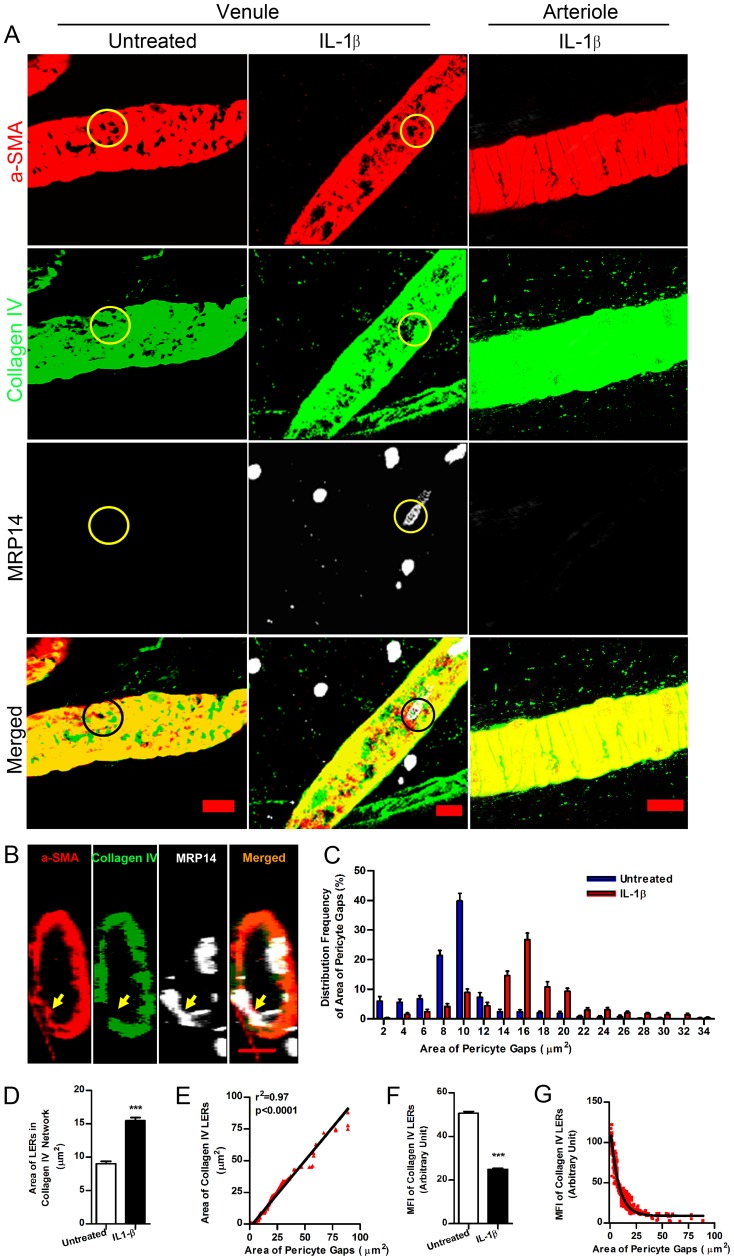
Expansion of pericyte gaps and collagen IV LERs in IL-1β-stimulated venular walls.(A) 3D images of vessel walls in mouse cremaster muscles in the presence and absence of IL-1β revealed pericyte gaps and collagen IV LERs (circled areas) in venules. α-SMA (a marker of venule pericytes and arteriole smooth muscles), collagen IV (a vascular BM marker) and MRP14 (a PMN marker). (B) Cross-sectional images revealed PMNs migrating through pericyte gaps and collagen IV LERs (arrows) in an IL-1β-stimulated venule. (C) Distribution frequency of area of pericyte gaps showed pericyte gap expansion induced by IL-1β (n = 2400). (D) Collagen IV LERs expanded in IL-1β-stimulated venular walls, compared to those in untreated vessels (In each group, n = 1500). (E) The area of pericyte gaps (n = 1500) was plotted against the area of collagen IV LERs (n = 1500). (F) Mean fluorescence intensity (MFI) of collagen IV in LERs decreased after IL-1β injection, indicating thinning of the vascular BM in these areas. (G) MFI of collagen IV in LERs was plotted against the size of pericyte gaps. Bar = 10 µm. t test, ***P<0.001.